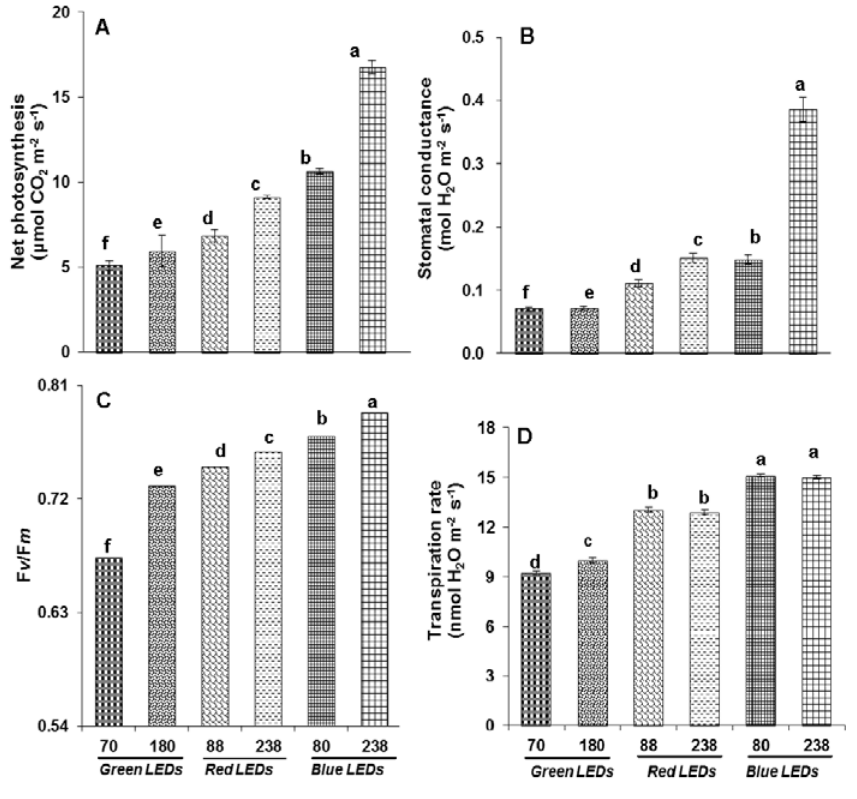
conductance; ( C ) Fv/Fm; and ( D ) Transpiration rate as affected by green, red and blue LEDs at different light intensities—green (70 and 180 μmol m −1 s −1 ), red (88 and 238 μmol m −1 s −1 ) and blue (80 and 238 μmol m −1 s −1 ). Vertical bars indicate ± SE of the means for n = 5. Means denoted by the different letter are significantly different at p < 0.05 according to